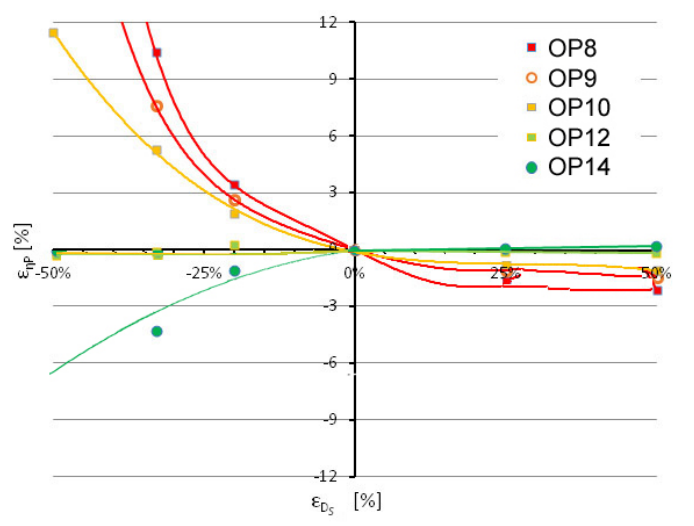
Figure 11. The algorithm sensitivity analysis for the determination of the pump efficiency (cid:101) η deviations in the input of the suction line diameter (cid:101) D OP12 and